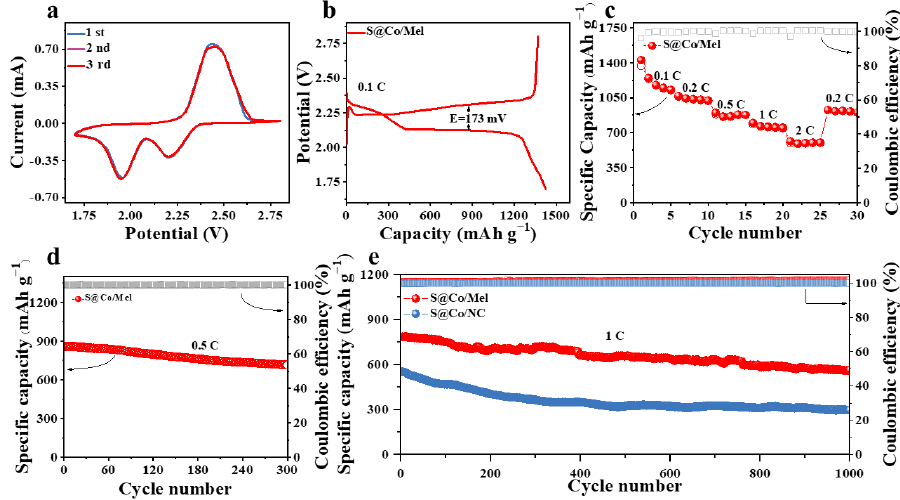
Figure 5. CV curves of S@Co/Mel for three initial cycles at the scan rate of 0.1 mV s − 1 ( a ); corresponding charge/discharge curve at 0.1 C ( b ); specific capacity at different C rates ( c ); cycling performance at 0.5 C ( d ) and 1 C ( e ) between 1.7–2.8 V.